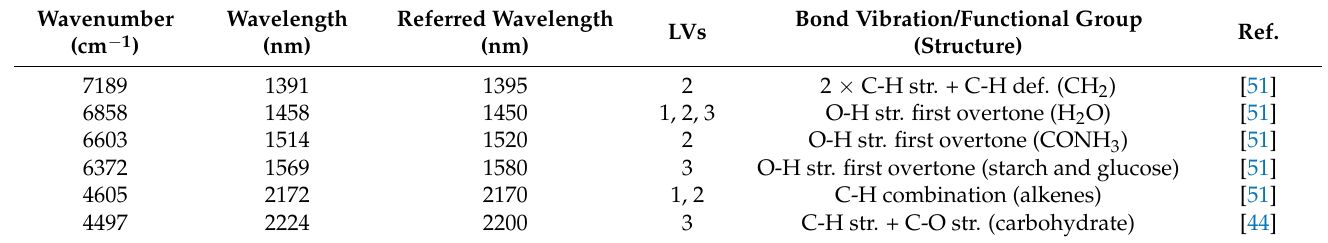
Table 13. The bands with a high X-loading weight of the PLSR model for TSS in mangosteen pur é e.